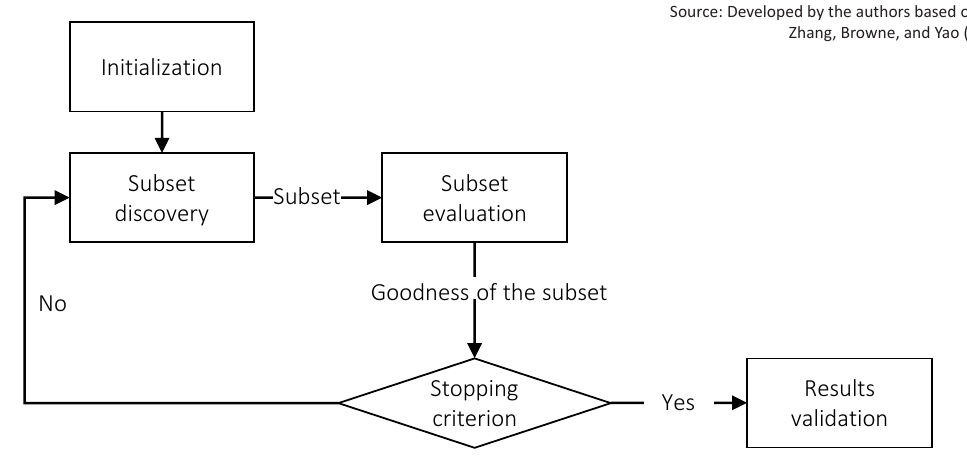
Figure 1. General feature selection process